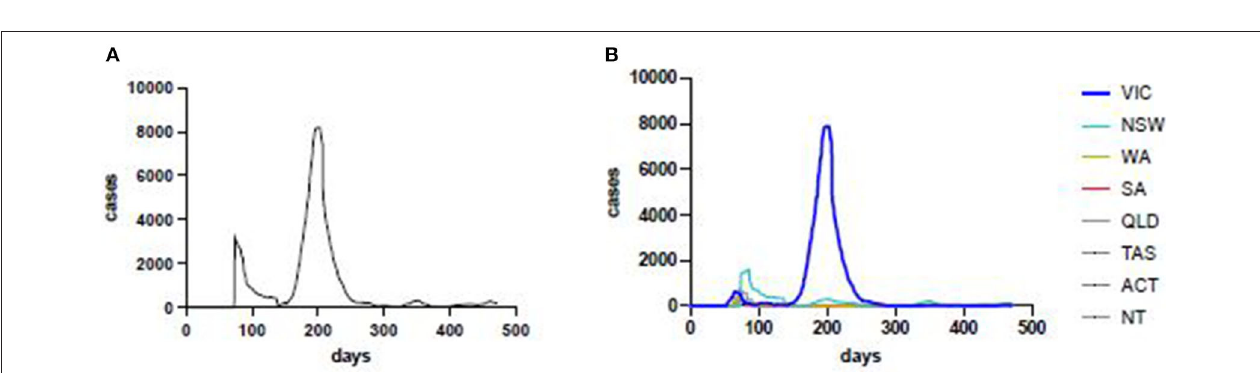
FIGURE 2 | Laboratory-confirmed COVID-19 cases, in Australia (left) and by state and territory (right). VIC, Victoria; NSW, New South Wales; WA, Western Australia; SA, South Australia; QLD, Queensland; TAS, Tasmania; ACT, Australian Capital Territory; NT, Northern